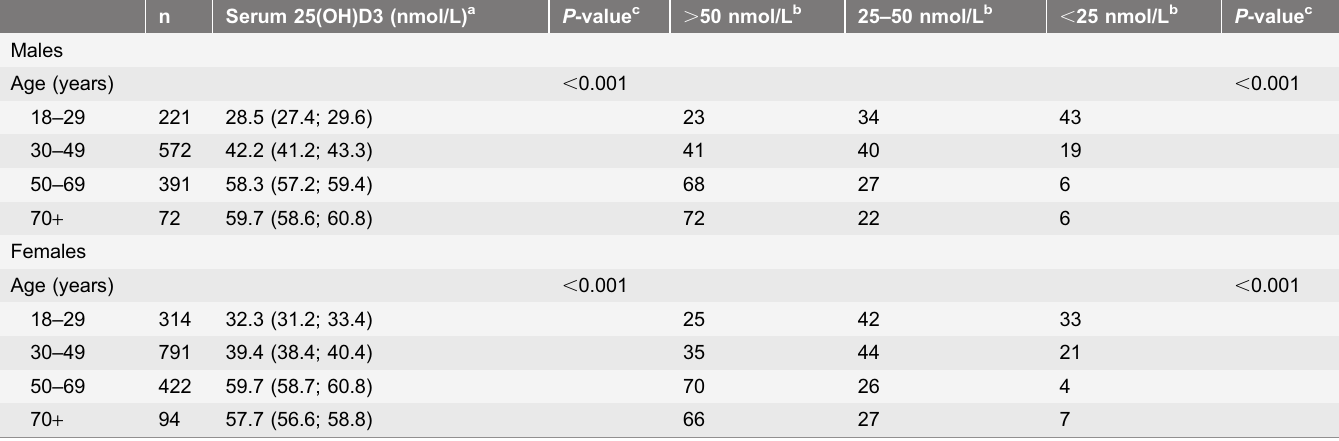
A characteristic seasonal variation in the prevalence of 25(OH)D3 concentra- tions less than 50 nmol/L and less than 25 nmol/L was observed ( Figure 3A ). The highest prevalences of concentrations less than 50 nmol/L and 25 nmol/L appeared in February to April and the lowest in August to September. There was a similar seasonal variation in serum 25(OH)D3 after adjustment for age, gender, and intake of traditional food ( Figure 3B ). Geometric mean serum 25(OH)D3 concentrations varied significantly (range 33.2–57.1 nmol/L, p , 0.001) over the nine months, with the highest concentrations in the summer and autumn. As presented in Table 3 , autumn season was a strong predictor of high serum 25(OH)D3 concentrations (47.1%; 95% CI: 35.8; 59.2; winter was reference), whereas increasing latitude predicted decreasing concentrations ( 2 0.7%; 95% CI: 2 1.3; 2 0.2). There was no interaction between season and latitude. Age (2.0%; 95% CI: 1.7; 2.2), female gender (7.1%; 95% CI: 2.0; 12.5), smoking ( 2 11.6%; 95% CI: 2 16.2; 2 6.9), alcohol (0.2%; 95% CI: 0.0; 0.4), BMI ( 2 0.6; 95% CI: 2 1.1; 2 0.2), supplementation with vitamin D or multivitamins (12.0%; 95% CI: 4.2; 20.4), and intake of traditional food (10.0%; 95% CI: 7.9; 12.1) were associated with serum 25(OH)D3 after full adjustment. Residence in a village versus a town appeared to be associated with higher serum 25(OH)D3, but the association was attenuated and became insignificant after adjustment for traditional food, season and latitude. Likewise, the association between socio- economic position and serum 25(OH)D3 disappeared after adjustment for traditional food, season and latitude. In general, adjustment for latitude only had small effects on the estimates.